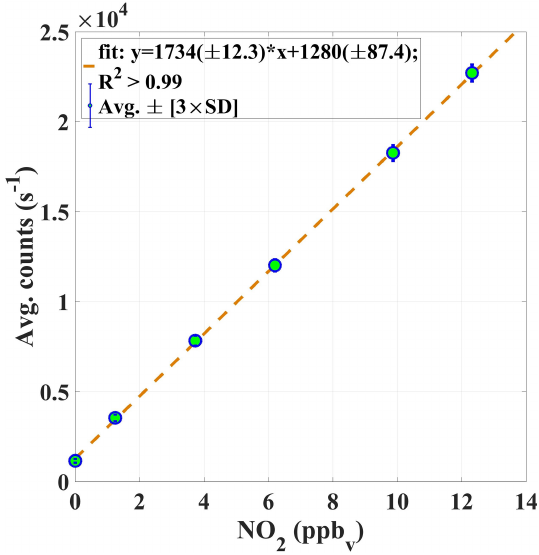
Figure 6. An example of the average PMT signal in counts (s − 1 ) vs. known mixing ratios of NO 2 . The calibration constant α c (Eq. 1) is given by the slope of the